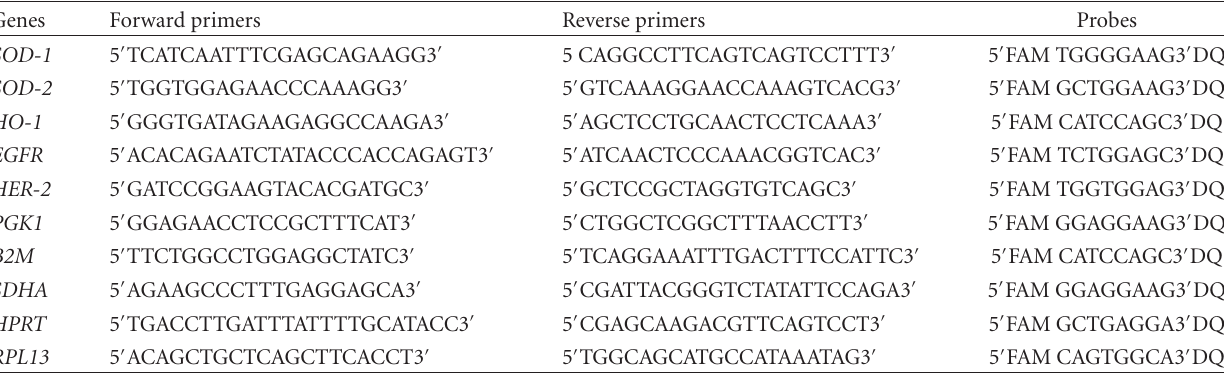
Table 1: Nucleotide sequences for primers and probes used in the present study.